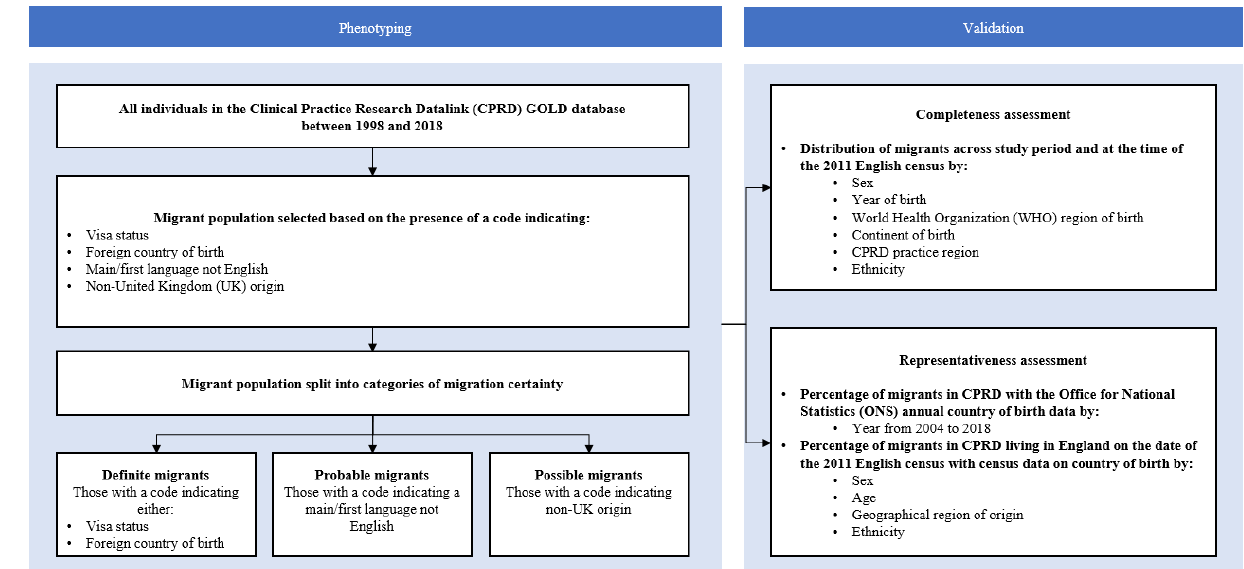
Figure 1. Study flow diagram.